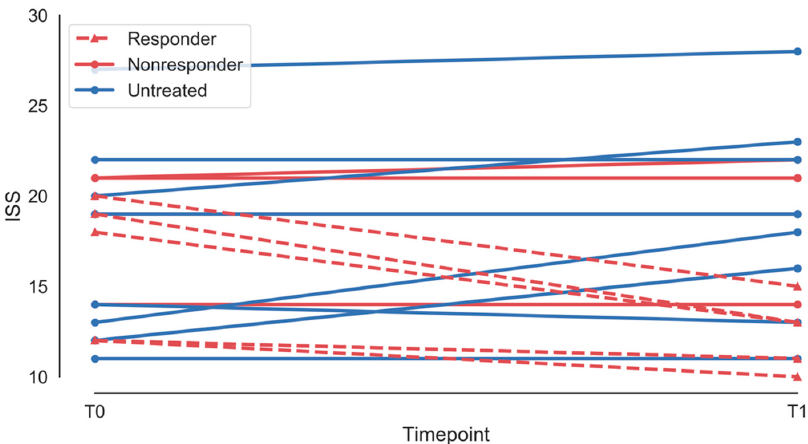
Figure 1. International severity score for treated (red) and untreated (blue) patients at baseline (T0) and at 12 months (T1). Responders are shown with a dashed line, nonresponders with a solid line.